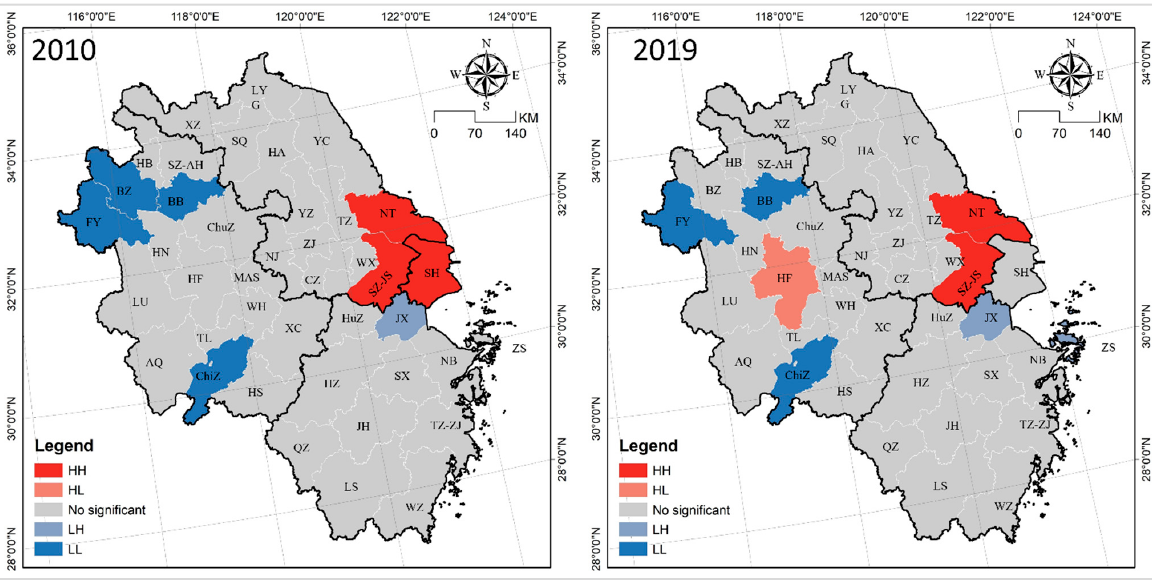
Figure 8. Spatial autocorrelation analysis of urban industrial land in the YRD.